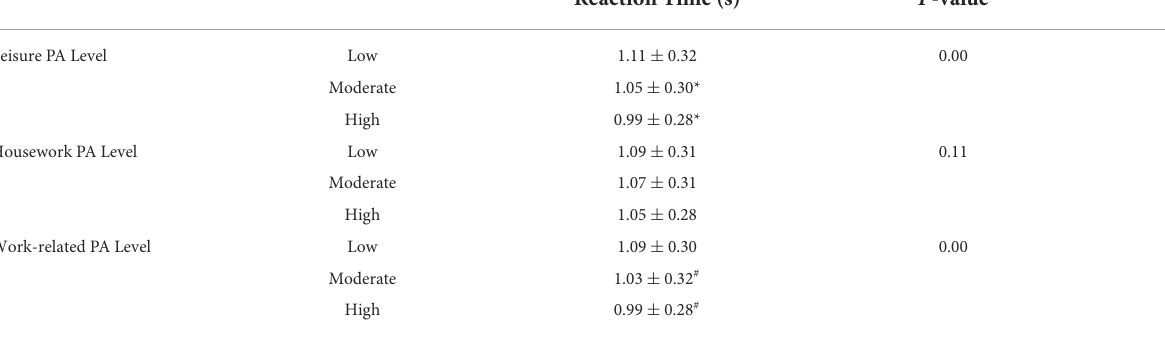
TABLE 4 The reaction time of participants with different levels of physical